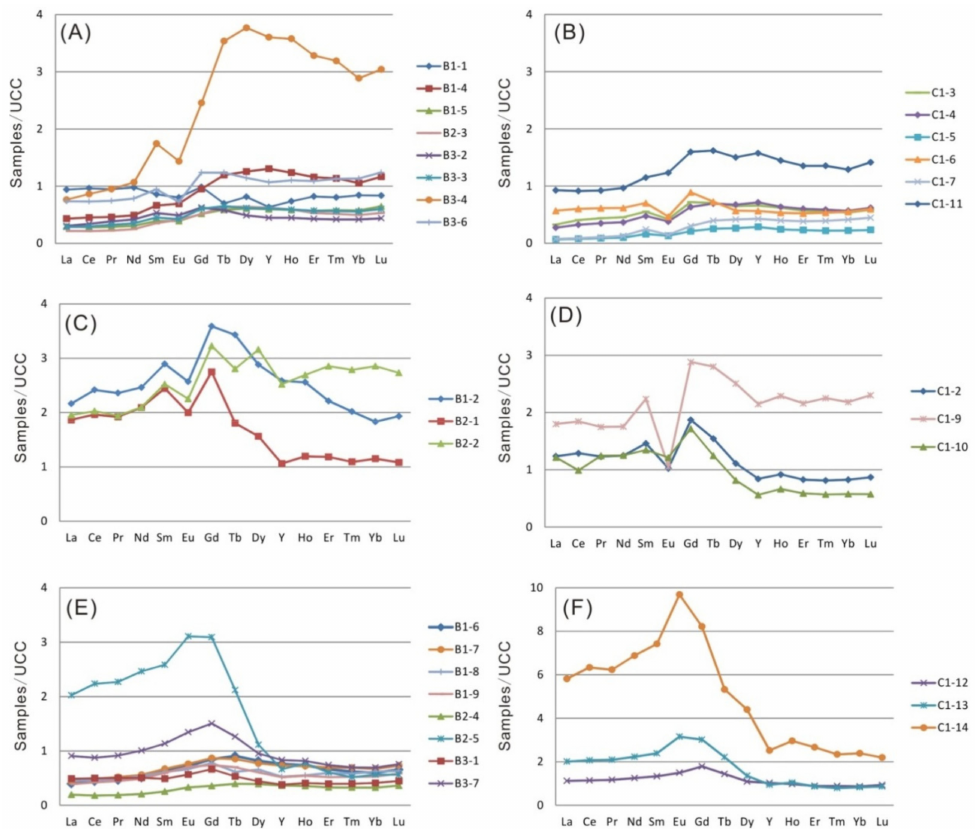
Figure 20. Distribution patterns of rare earth elements and yttrium in the coal samples. ( A , B ), Samples in the first group characterized by a weak Eu negative anomaly. ( C , D ), Samples in the second group characterized by a clear Eu negative anomaly. ( E , F ), Samples in the third group characterized by a Gd-maximum anomaly, except C1-13 and C1-14 that have Eu-maximum. REY are normalized to an Upper Continental Crust (UCC)